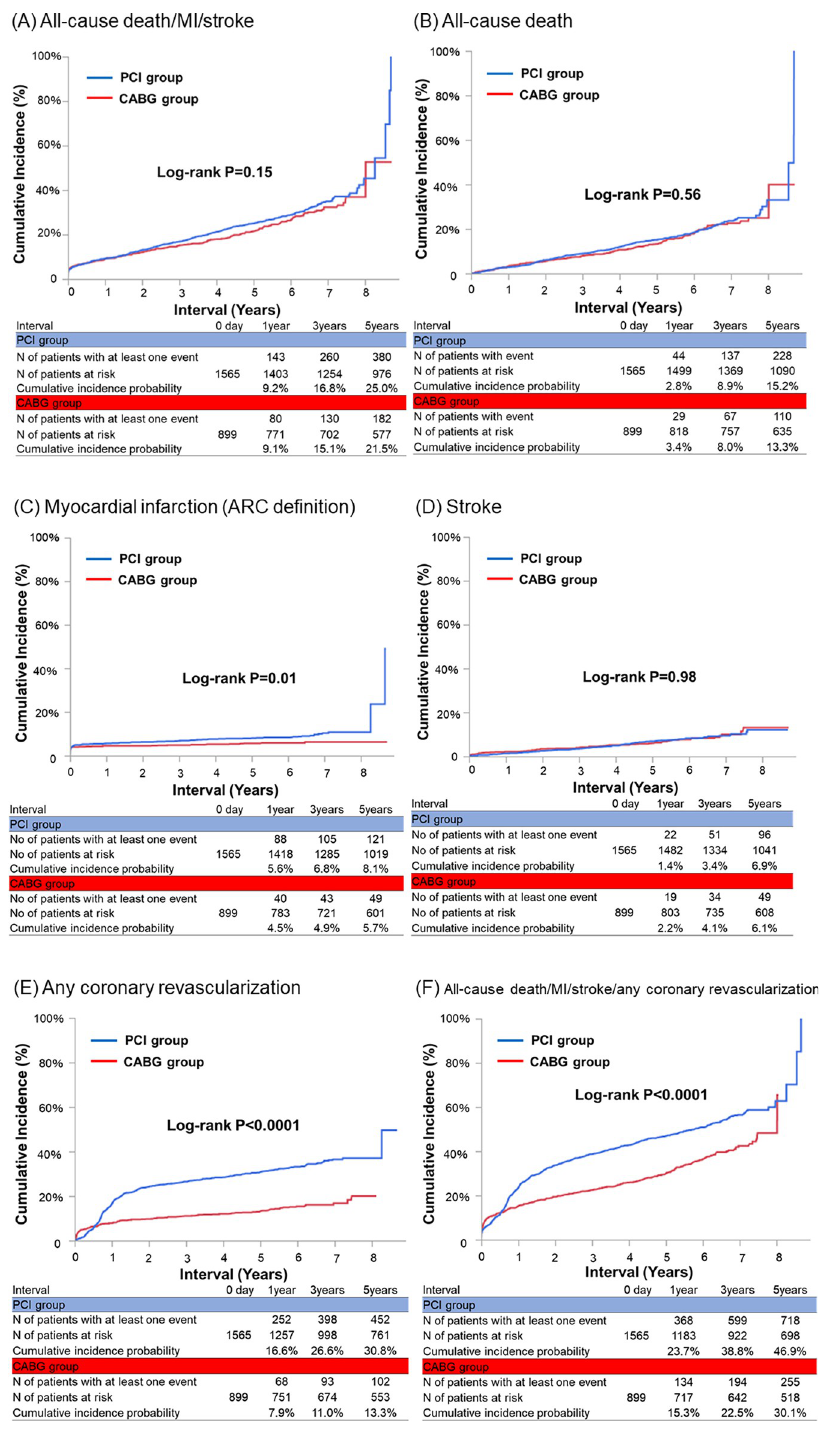
Fig 2. Crude kaplan-meier curves for the cumulative incidence of (A) all-cause death/MI/stroke, (B) all-cause death, (C) any coronary revascularization, and (D) all-cause death/MI/stroke/any coronary revascularization. PCI = percutaneous coronary intervention; CABG = coronary artery bypass grafting; MI = myocardial infarction.